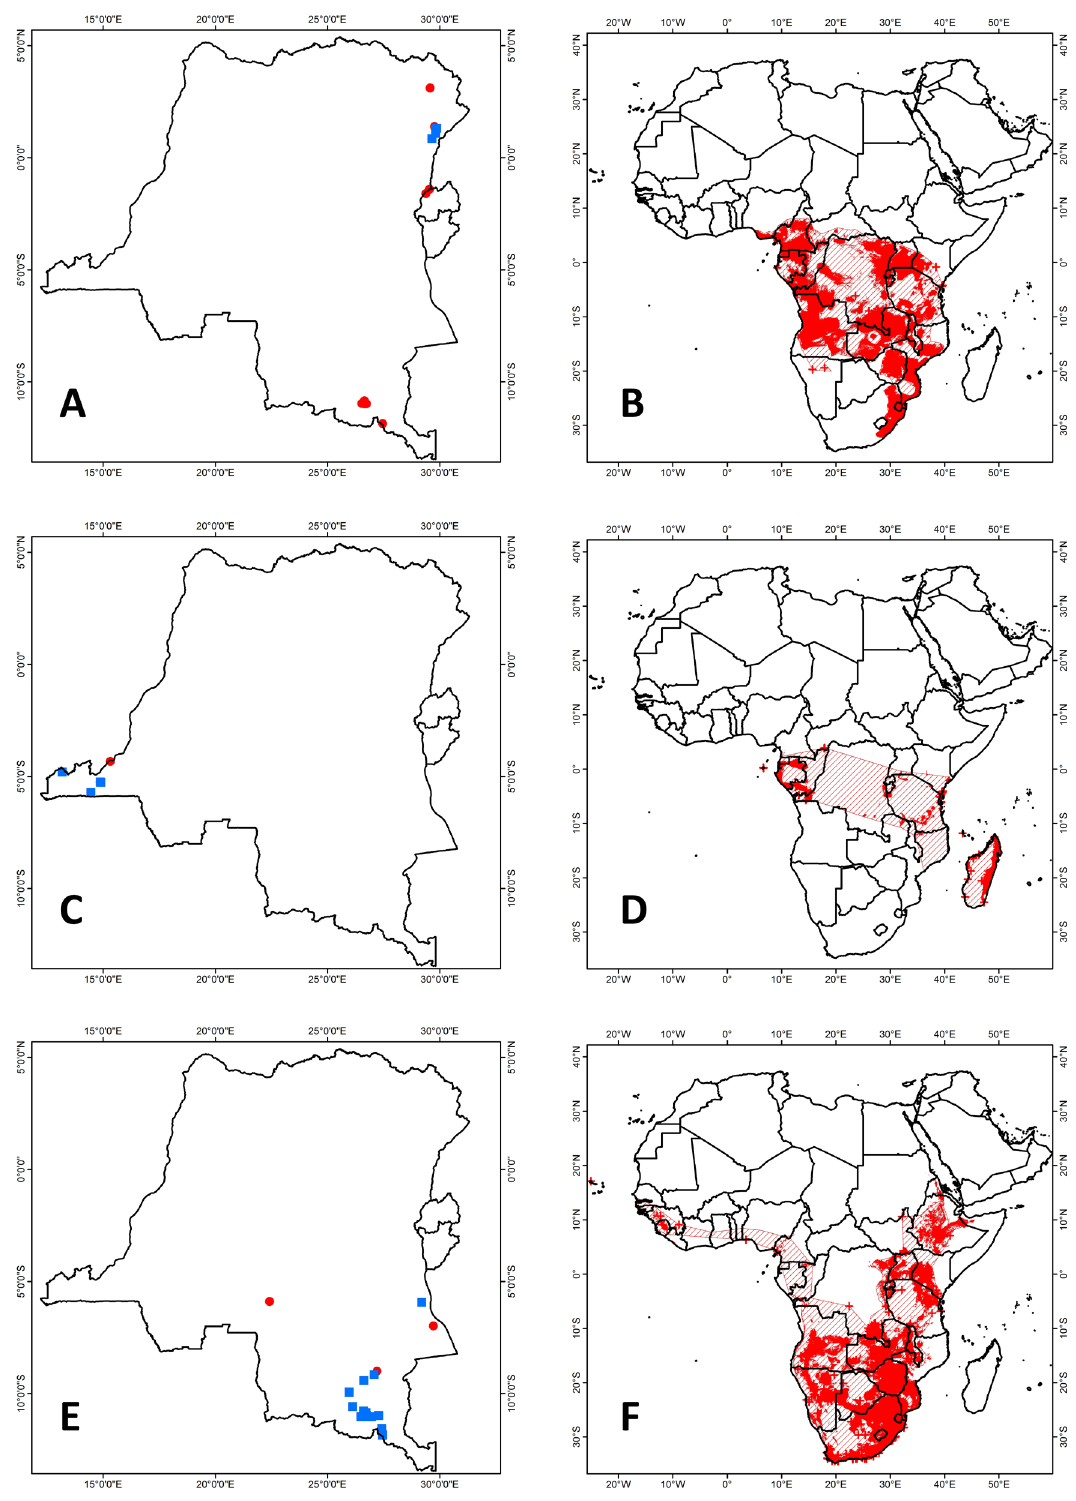
Fig. 33. Distribution maps. A–B . Miniopterus inflatus Thomas, 1903. C–D . Miniopterus minor Peters, 1867. E–F . Miniopterus natalensis (A. Smith, 1833). A, C, E. Distribution in the CRB area. B, D, F. Pan-African